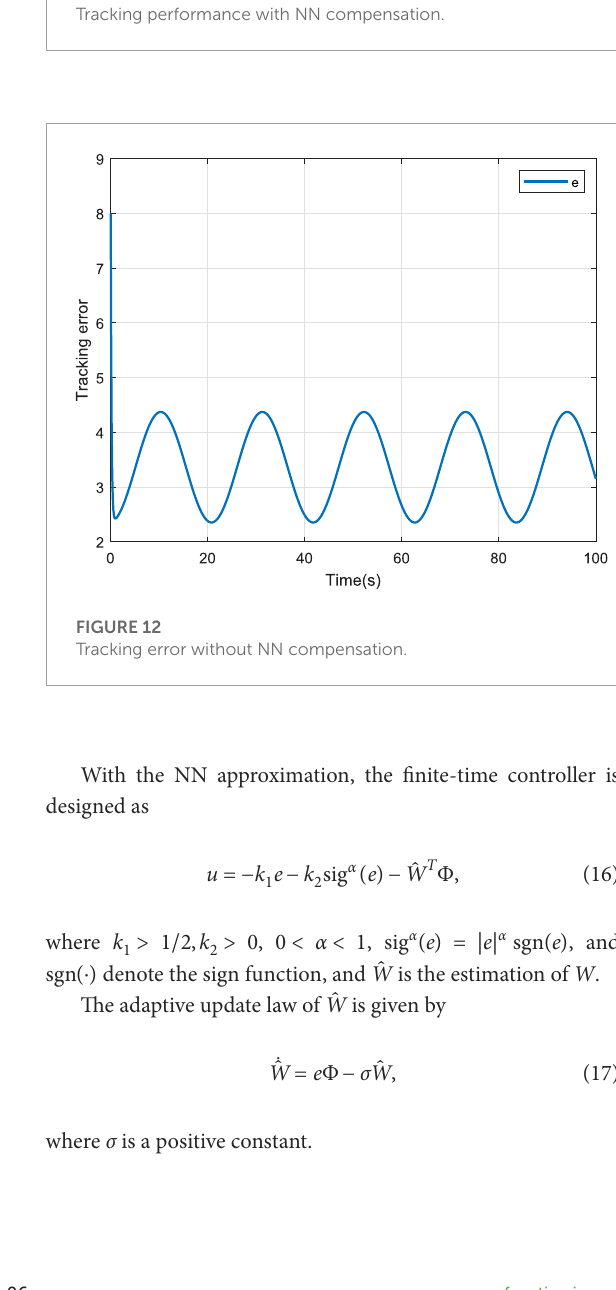
FIGURE 11 Tracking performance with NN compensation.